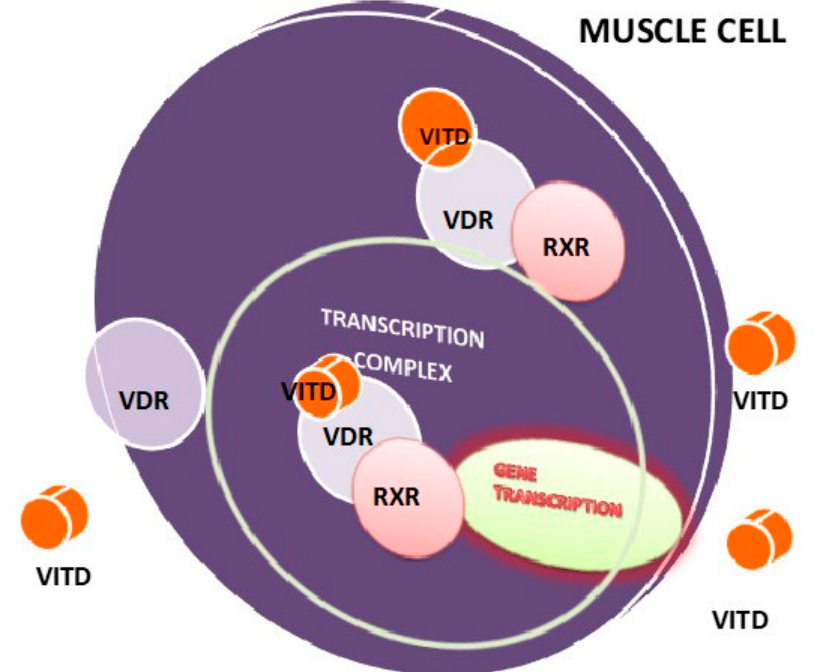
Figure 2. Proposed model for effect of vitamin D on skeletal muscle. Circulating and locally converted 1,25(OH)2D3 have been proposed to act on skeletal muscle through the vitamin D receptor (VDR). The VDR is located both within the nucleus, which results in genomic actions, and outside of the nucleus, which may cause acute nongenomic signaling events.